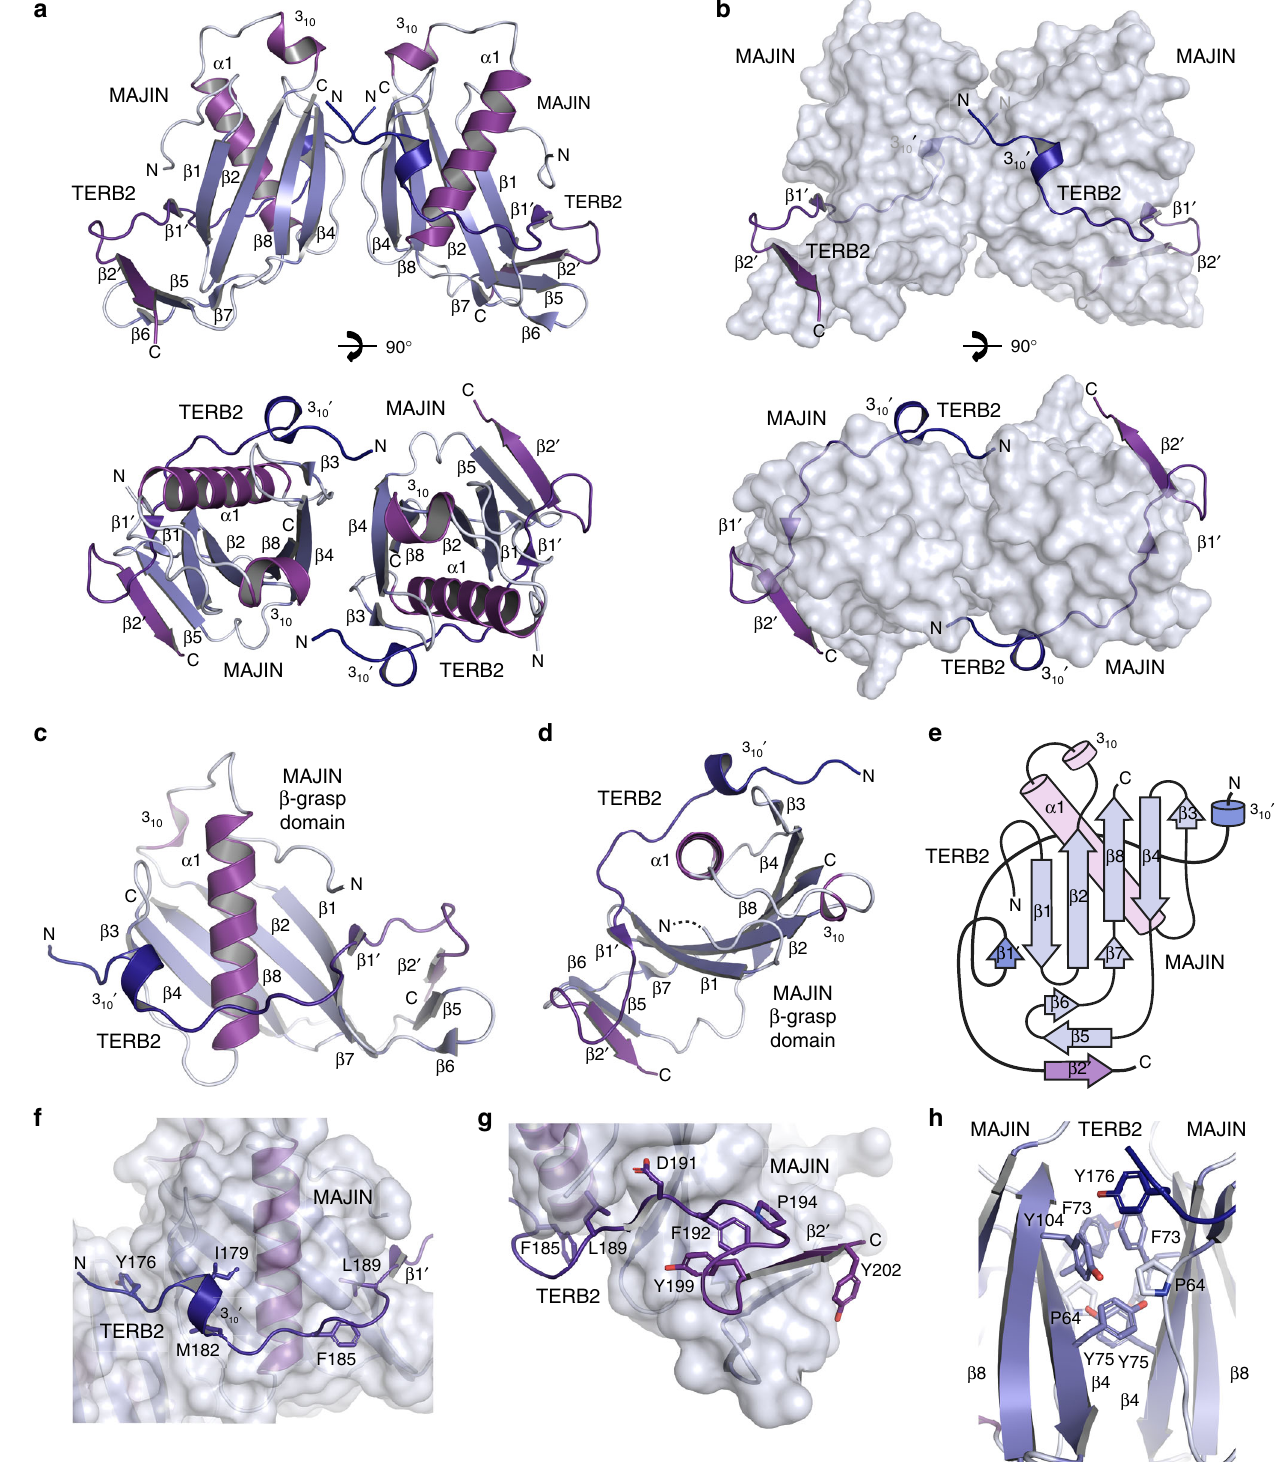
DNA-binding by MAJIN – TERB2 . The MAJIN – TERB2 structure shows an extensive basic patch on the surface of each protomer, formed of highly conserved amino acids in the grasping β -sheet of MAJIN (Fig. 4a, b and Supplementary Fig. 3e), suggesting that it may mediate direct DNA-binding through electrostatic interac- tion with the phosphodiester backbone. Accordingly, analysis of MAJIN Core -TERB2 C by electrophoretic mobility shift